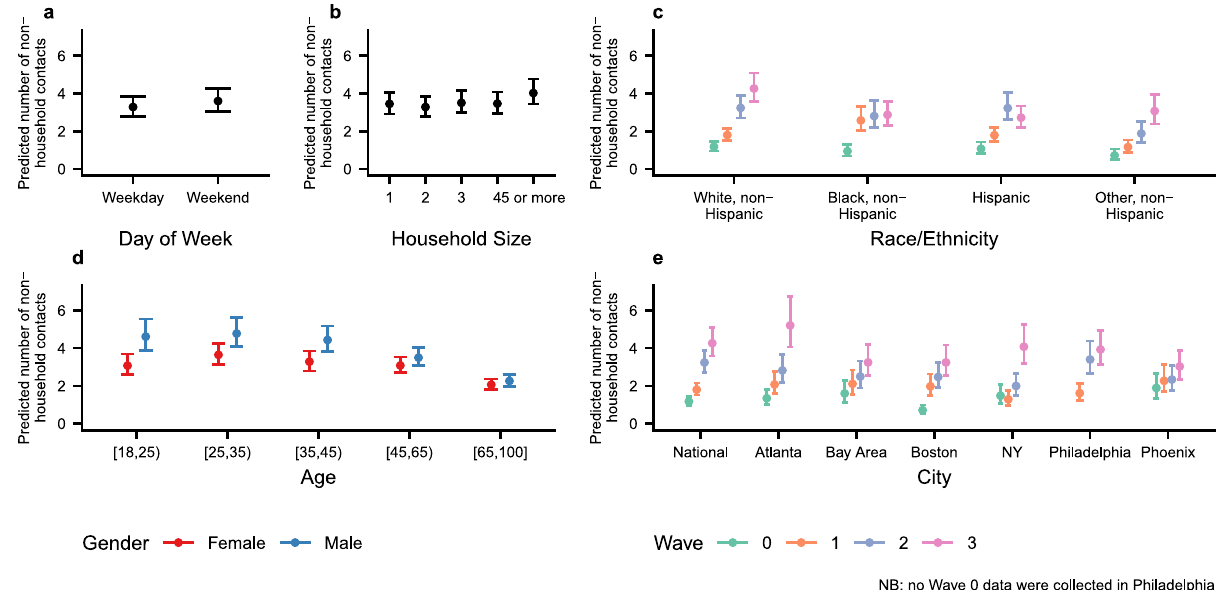
Fig. 2 Conditional effect plots showing the predicted mean number of non-household contacts and 95% posterior credible intervals for several covariates. Predicted mean number of non-household contacts is shown for ( a ) day of the week; ( b ) household size; ( c ) race/ethnicity; ( d ) age/sex group; and ( e ) geography. Predictions come from a negative binomial model fi t to reported numbers of non-household contacts made by n = 9743 survey respondents. Colors are used in panels c – e to show estimated interactions. Covariate values not being manipulated in each panel are set to values for a white female aged 35 – 44 from the national sample who lives in a two-person household during a weekday in wave 3 ( “ Methods ” ). Uncertainty bars show 95% posterior credible intervals. Supplementary Fig. 2 shows the same predictions for an analogous model fi t to all